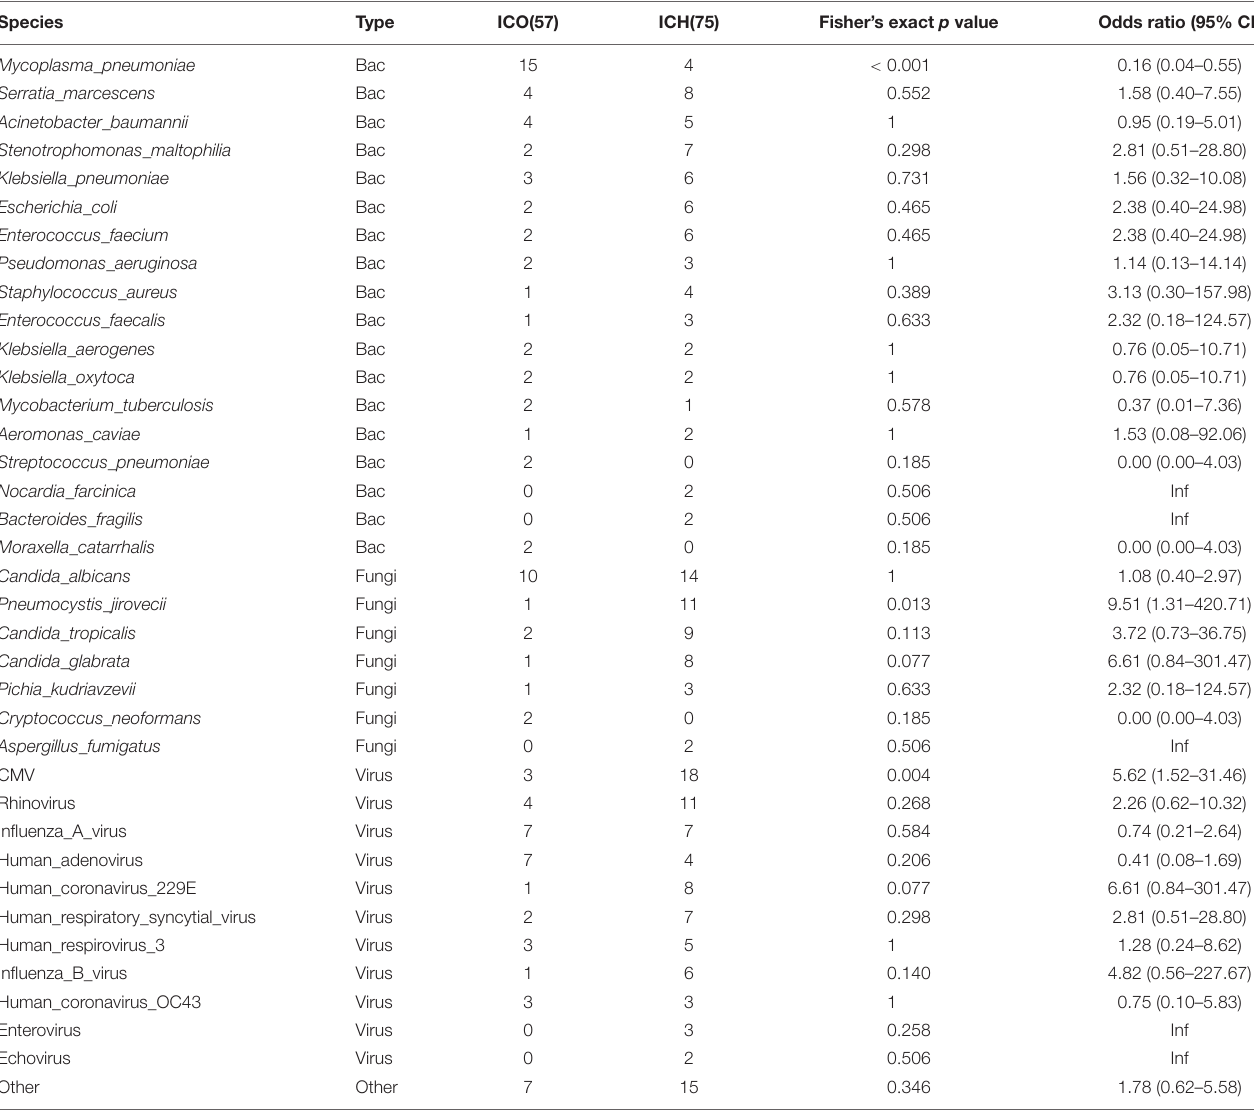
TABLE 5 | Microbial spectra differ between ICH and ICO patients with pneumonia. Species